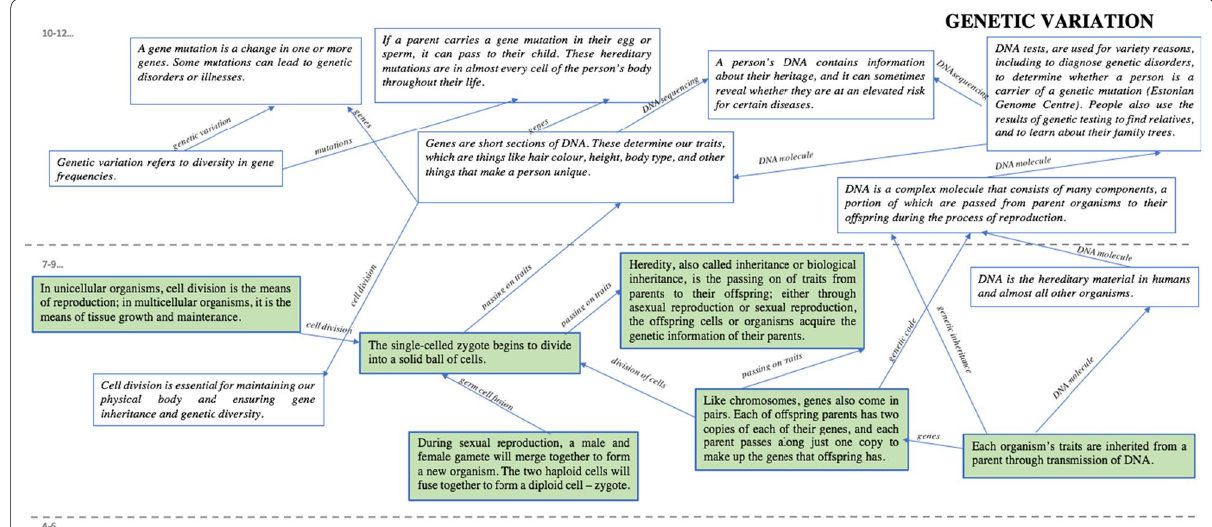
Fig. 1 Part example of students expanded disciplinary core idea map, based on AAAS